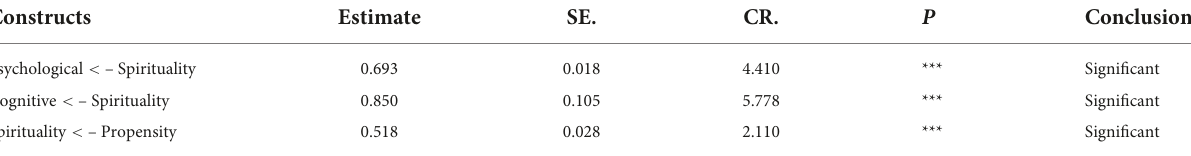
TABLE 2 Summary of the structural equation modeling.